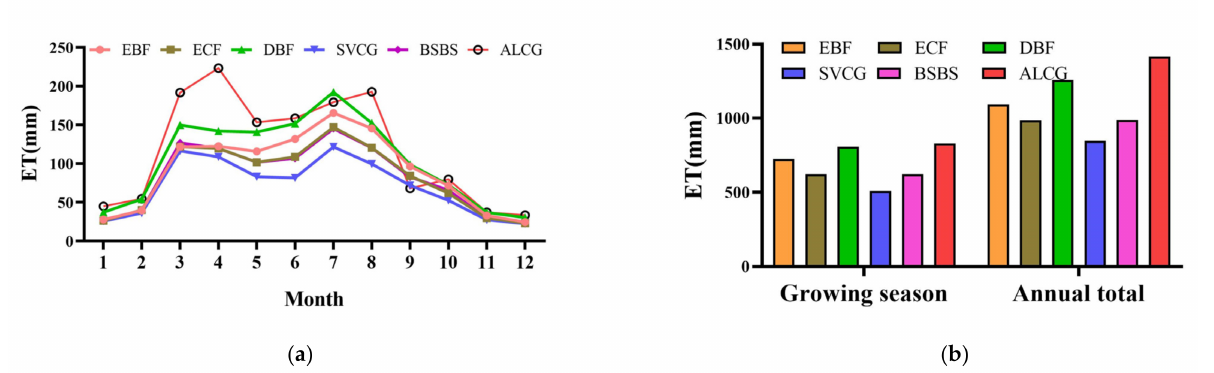
Figure 7. Seasonal dynamics of ET for different vegetation. ( a ) is the monthly ET of the six vegetation types. ( b ) is the sum of the monthly ET of the six vegetation types for the growing season and in a